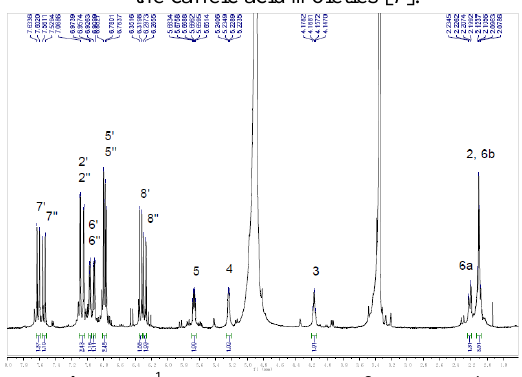
Figure 3. 1 H NMR spectrum of compound 3